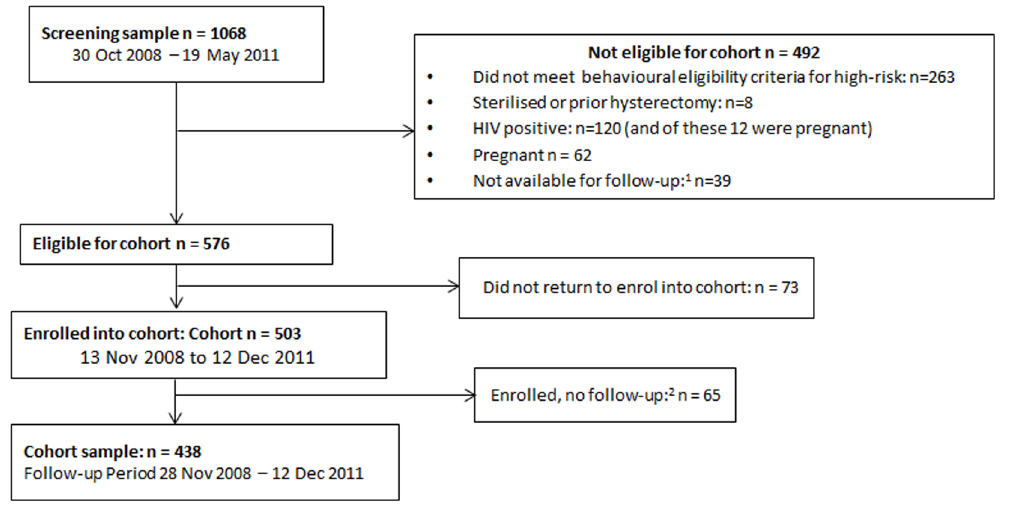
Figure 1. Flowchart to derive analytic sample. 1 n=38 relocating and n=1 refused follow-up 2 Follow up period was cut short for administrative reasons (funding halted) so 26 of the 65 women contributed no follow up time.